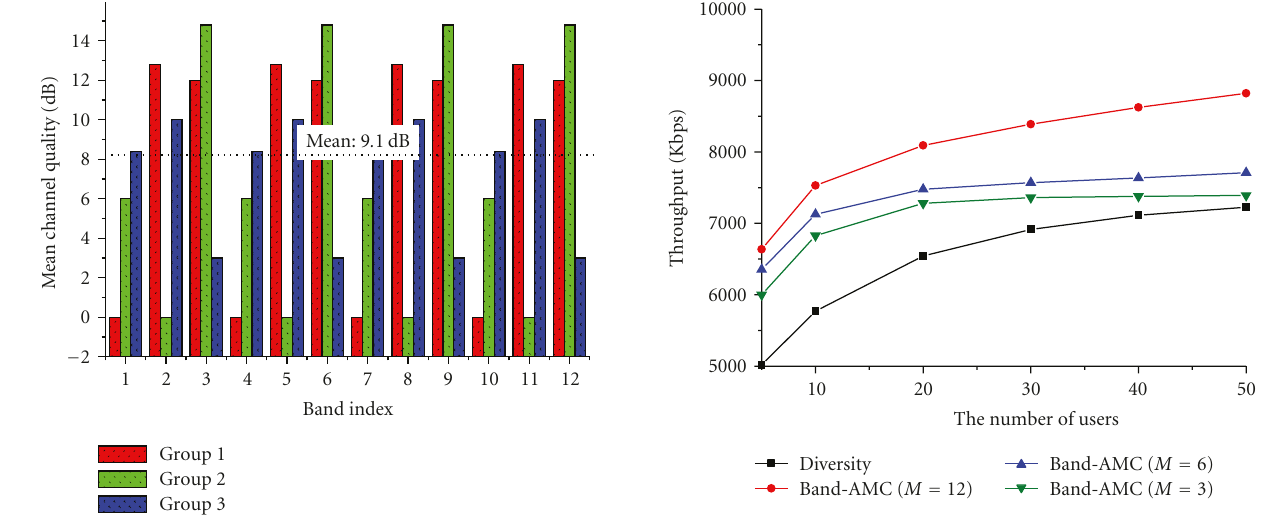
Figure 5: Example of mean channel quality: L = 3 .